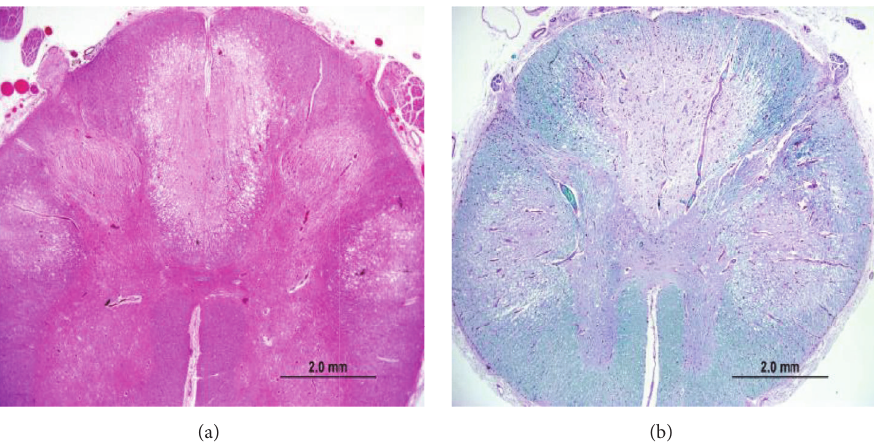
Figure 3: Histologic sections of spinal cord demonstrate extensive white matter pathology. (a) Low-power photomicrograph of spinal cord with dorsal column and lateral white matter degeneration (original magnification, × 20; hematoxylin-eosin [H-E] stain); (b) low-power photomicrograph of spinal cord stained with Luxol fast blue-periodic acid Schiff (LFB-PAS) histochemistry to demonstrate loss of myelinated axons (original magnification, × 20; LFB-PAS stain).